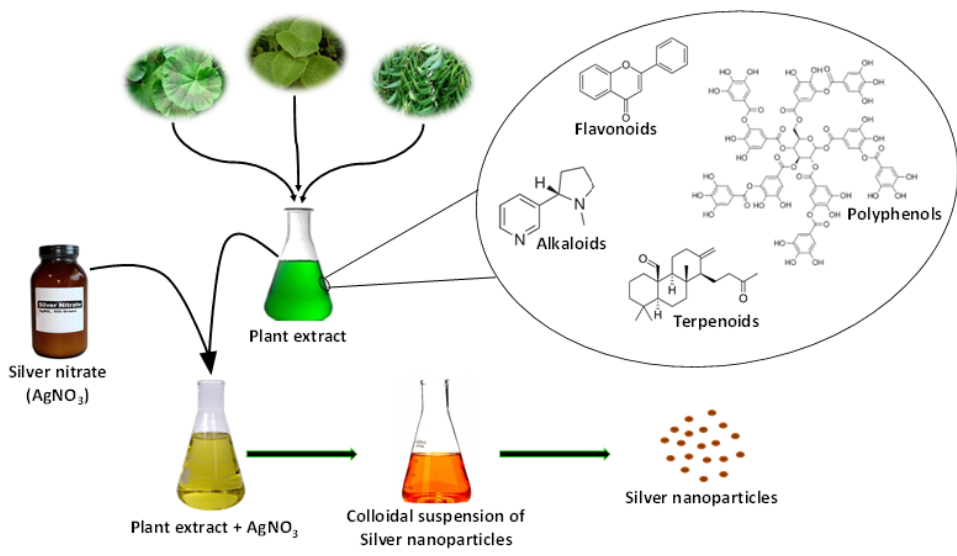
Figure 7. General mechanism involved in the phytosynthesis of AgNPs.